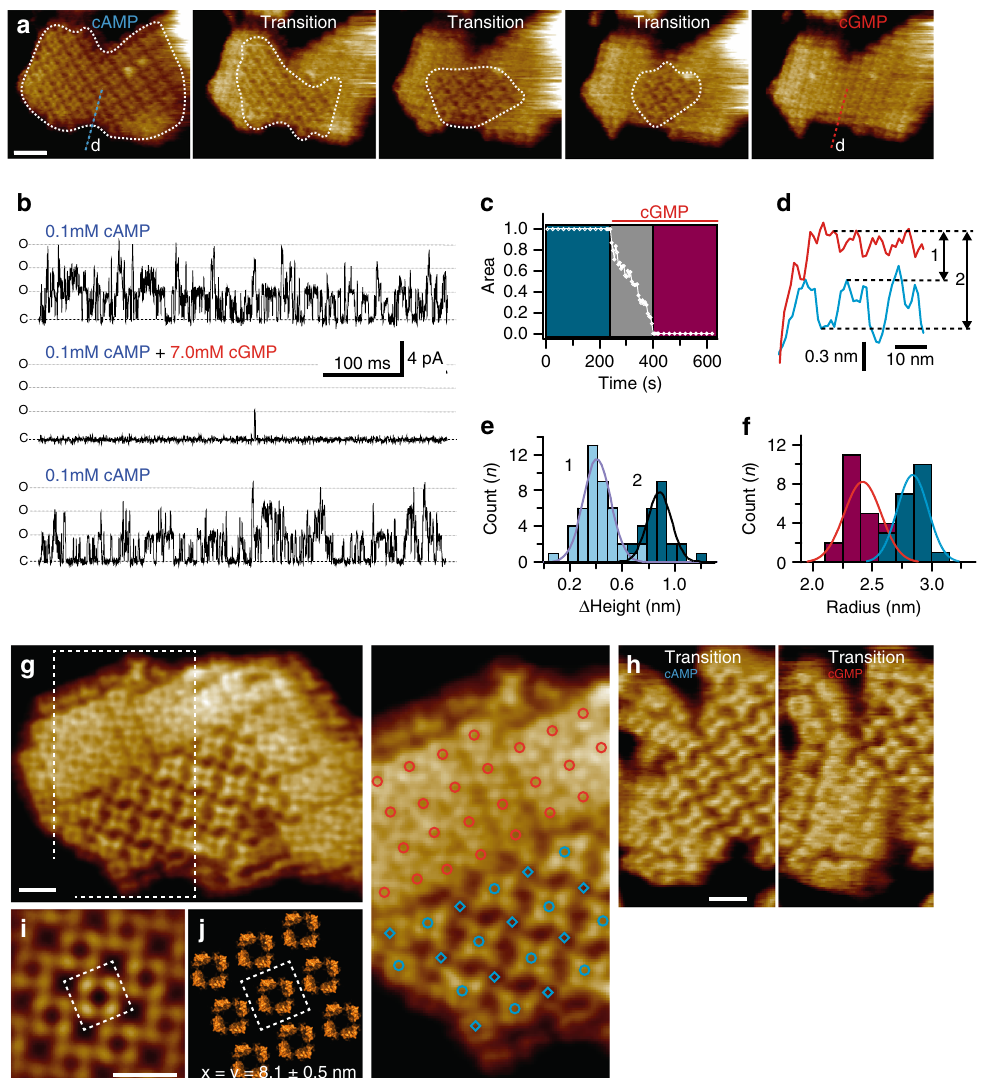
Fig. 3 Dynamics of ligand-induced conformational changes in SthK by real-time HS-AFM imaging. a HS-AFM time-lapse high-resolution image sequence of a SthK 2D-crystal initially in 0.1 mM cAMP and exposing CNBDs. Upon addition of 7 mM cGMP, SthK channels undergo a conformational change progressively from the borders to the center of the membrane patch (dotted while outline). Scale bar: 30 nm. b Representative electrophysiology traces from SthK channels in the presence of 0.1 mM cAMP (top and bottom traces), and 7 mM cGMP and 0.1 mM cAMP (middle trace). Activity from the same bilayer, perfused to different solutions is displayed to enable direct comparisons. C and O are closed and open channel levels, respectively. Three channels appear active, each with a Po of ~0.25 at 0.1 mM cAMP. c Kinetics of cAMP to cGMP conformational transitions of the 2D-crystal shown in a . d Height pro fi les along the blue (cAMP) and red (cGMP) dashed lines in a . e Distributions of the relative height differences of the very same molecules in the cGMP conformation and the higher (1) and lower (2) molecules in the cAMP conformation. f Histograms of the radial distance of the cAMP (blue) and cGMP (red) CNBDs from the central four-fold axis. g Left: High-resolution topography of a membrane containing well-ordered channels in both conformations. Right: Zoom into region outlined in g with overlaid red circles for the resting state channels and blue circles (upper molecules) and blue rhomboids (lower molecules) in the activated state. The crystal was imaged in the presence of 0.1 mM cAMP and was one of a handful of membranes that contained resting and activated state molecules simultaneously (scale bar: 10 nm). h High-resolution topographs during a cAMP to cGMP transition where the majority of the molecules are in the cAMP (left) and in the cGMP (right) conformation, respectively (scale bar: 10 nm). i Correlation average of the resting state 2D-crystal in g . Scale bar: 10 nm. j Packing model of the 2D-crystal using the SthK structure (PDB 6CJQ). The unit cell (dashed square in i and j , dimensions a = b = 8.1 nm, γ = 90°), comprises one